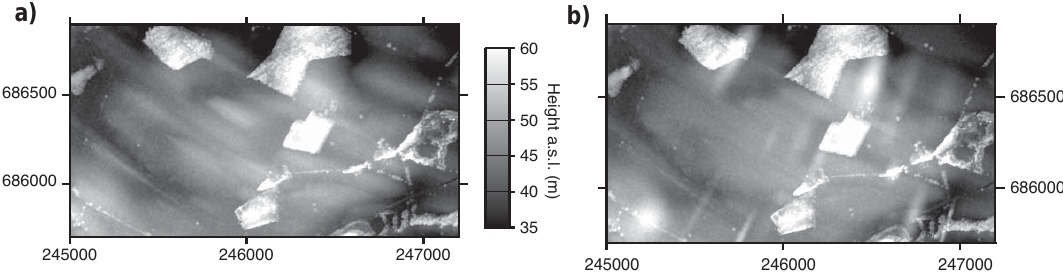
Figure 7. Illustration of a real DEM in (a) and a “hybrid” synthetic generated from (b) . Method used is as in Fig. 6 (Hillier and Smith, 2012), adapted to locally align drumlins with each other (Hillier et al., 2014). Map coordinates are of the British National Grid (5m grid). Synthetic drumlins were orientated at 90 ◦ to the original ones to avoid any possible confusion with any incompletely removed original ice-flow fabric during the mapping